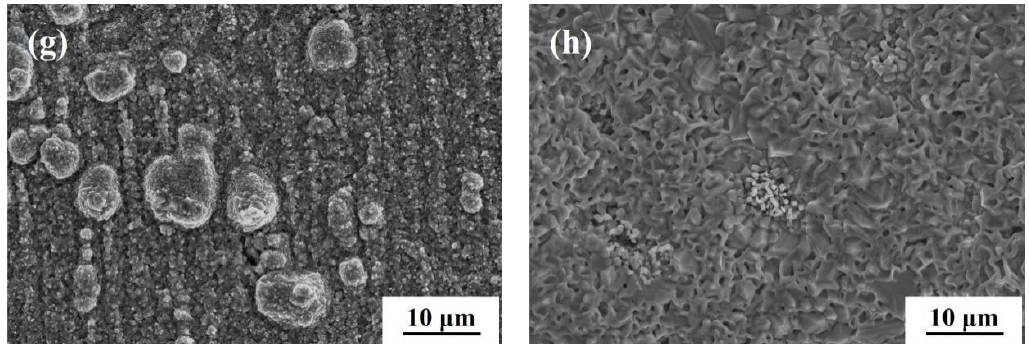
Figure 3. SEM images of the surface morphology of 22Cr25NiWCoCu stainless steels after oxidation in ambient air ( a ) with 0% for 10 h, ( b ) with 0% for 150 h, ( c ) with 0.29% for 10 h, ( d ) with 0.29% for 150 h, ( e ) with 0.58% for 10 h, ( f ) with 0.58% for 150 h, ( g ) with 0.86% for 10 h, and ( h ) with 0.86% for 150 h.